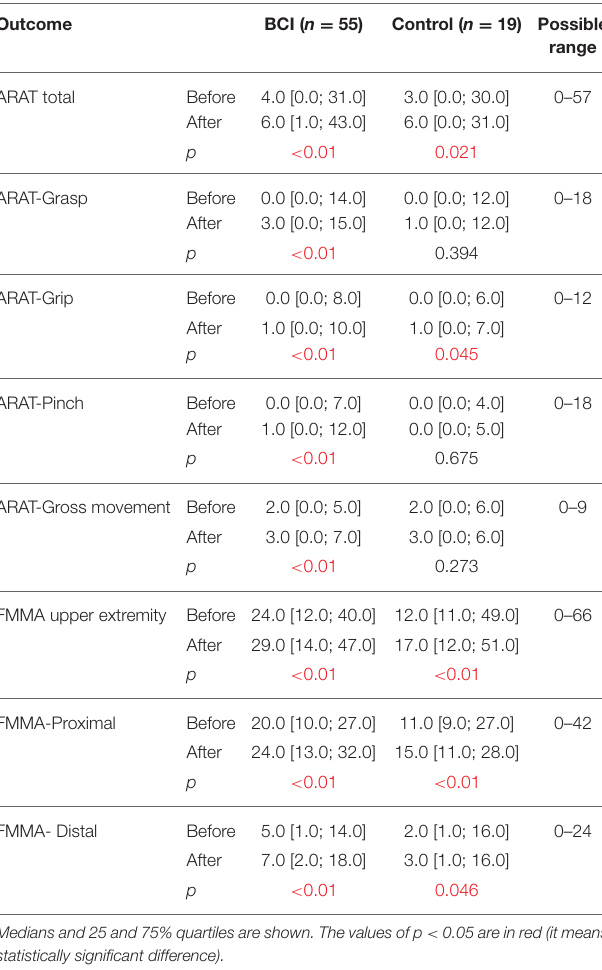
chronic ( Table 5 ) stroke. For both subacute ( Table 4 ) and chronic ( Table 5 ) cohorts the percentage of patients who achieved MCID was higher in the BCI